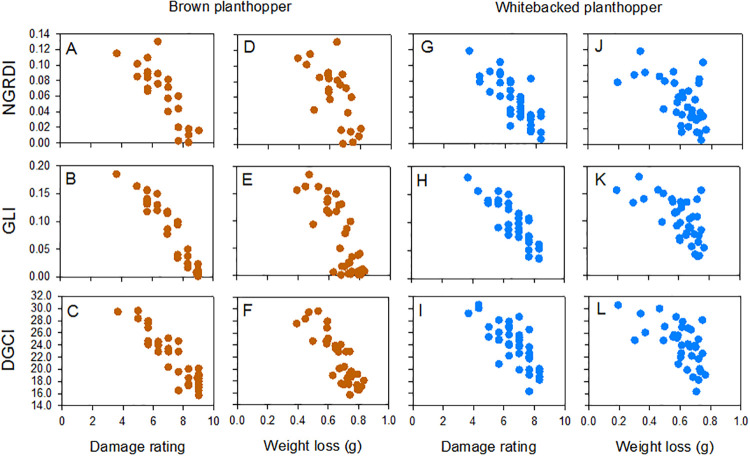
Correlations between colour indices and damage ratings or estimated weight-losses for 37 rice varieties after Standard Seedling Seed-box Tests with (A-F) the brown planthopper and (G-L) the whitebacked planthopper. NGRDI, GLI and DGCI were better correlated with damage ratings for the brown planthopper (A, B and C, respectively) than for the whitebacked planthopper (G, H and I, respectively). NGRDI, GLI and DGCI were better correlated with damage ratings (A-C, G-I) than with corresponding estimates of plant weight loss (D-F, J-L). Correlation coefficients are indicated in Table 1. Values for damage ratings and weight losses for each variety are presented in S3 and S4 Tables. Note that DGCI values are inversed in the figure.